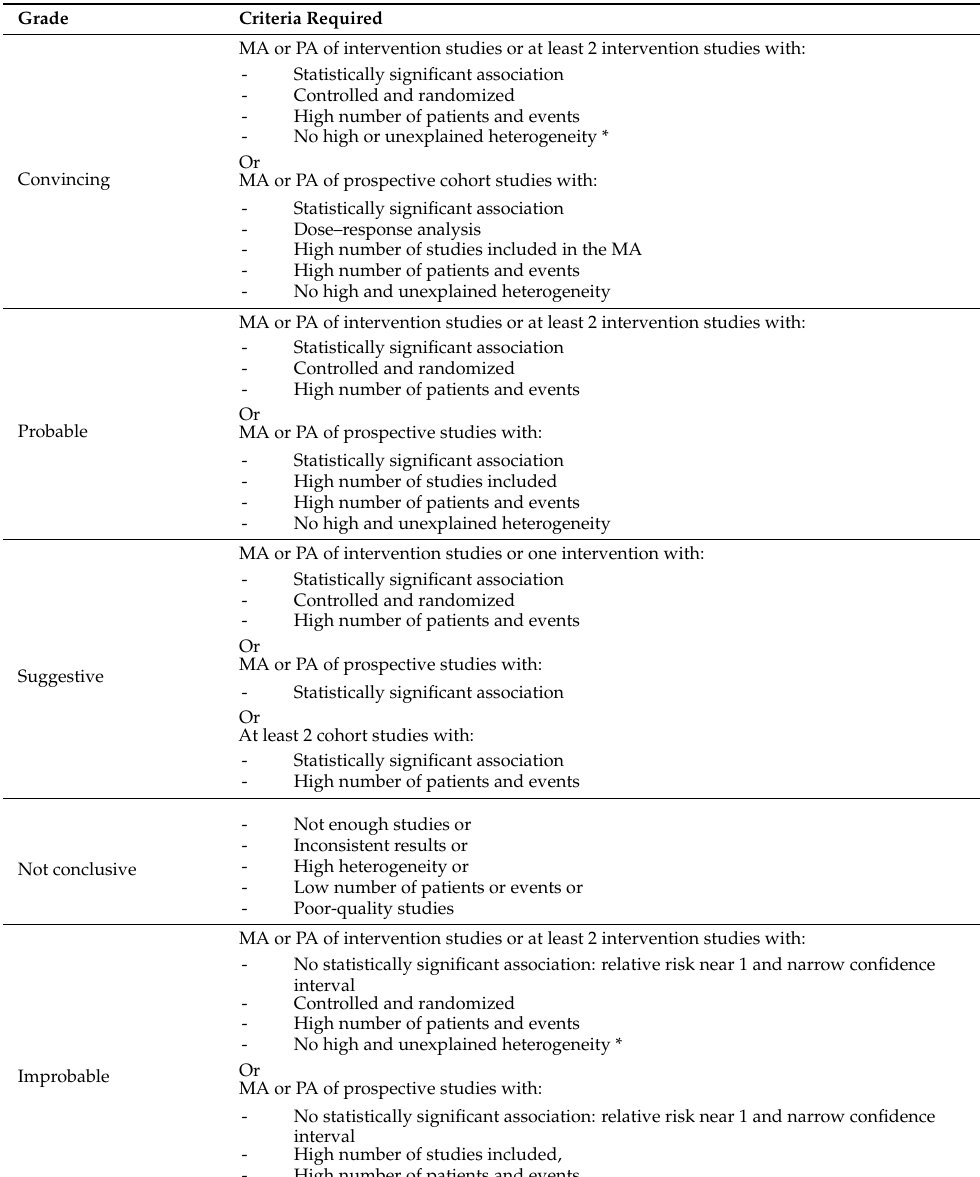
Table 1. Criteria used by the INCa expert for evaluating the levels of